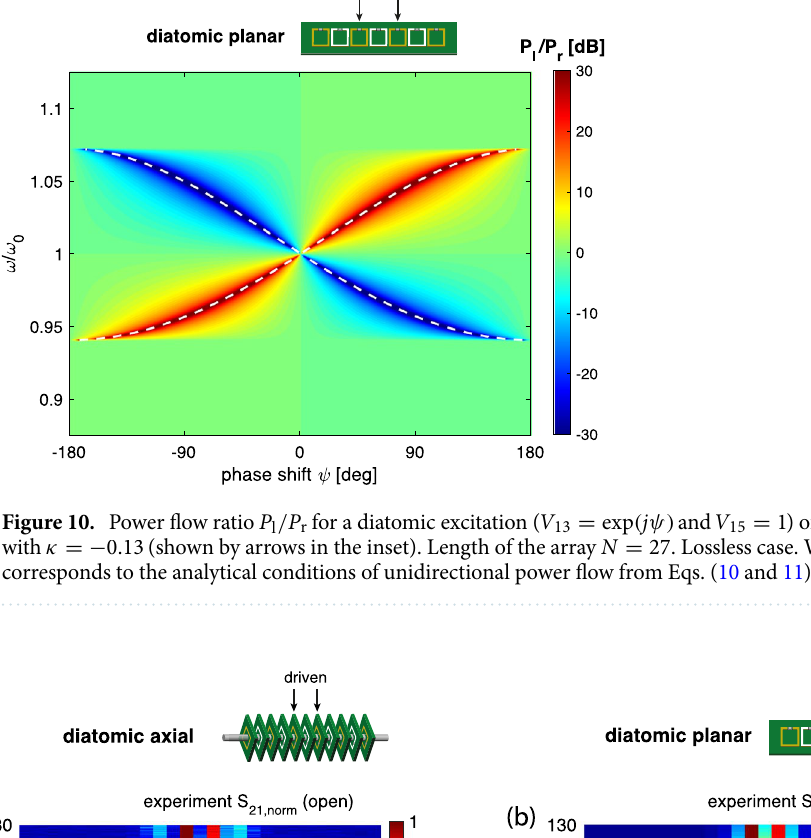
Figure 10. Power flow ratio P l / P r for a diatomic excitation ( V 13 0.13 (shown by arrows in the inset). Length of the array N with κ = − corresponds to the analytical conditions of unidirectional power flow from Eqs. (10 and 11).